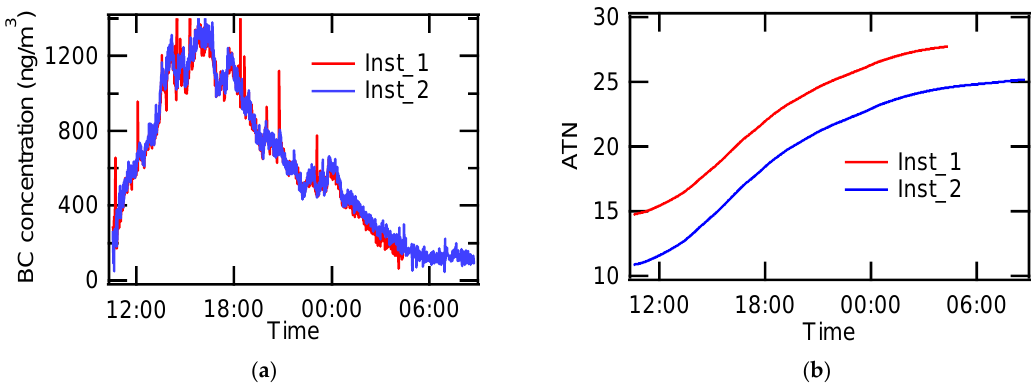
Figure 2. ( a ) Black carbon (BC) concentrations and ( b ) attenuation (ATN) values obtained from both instruments.